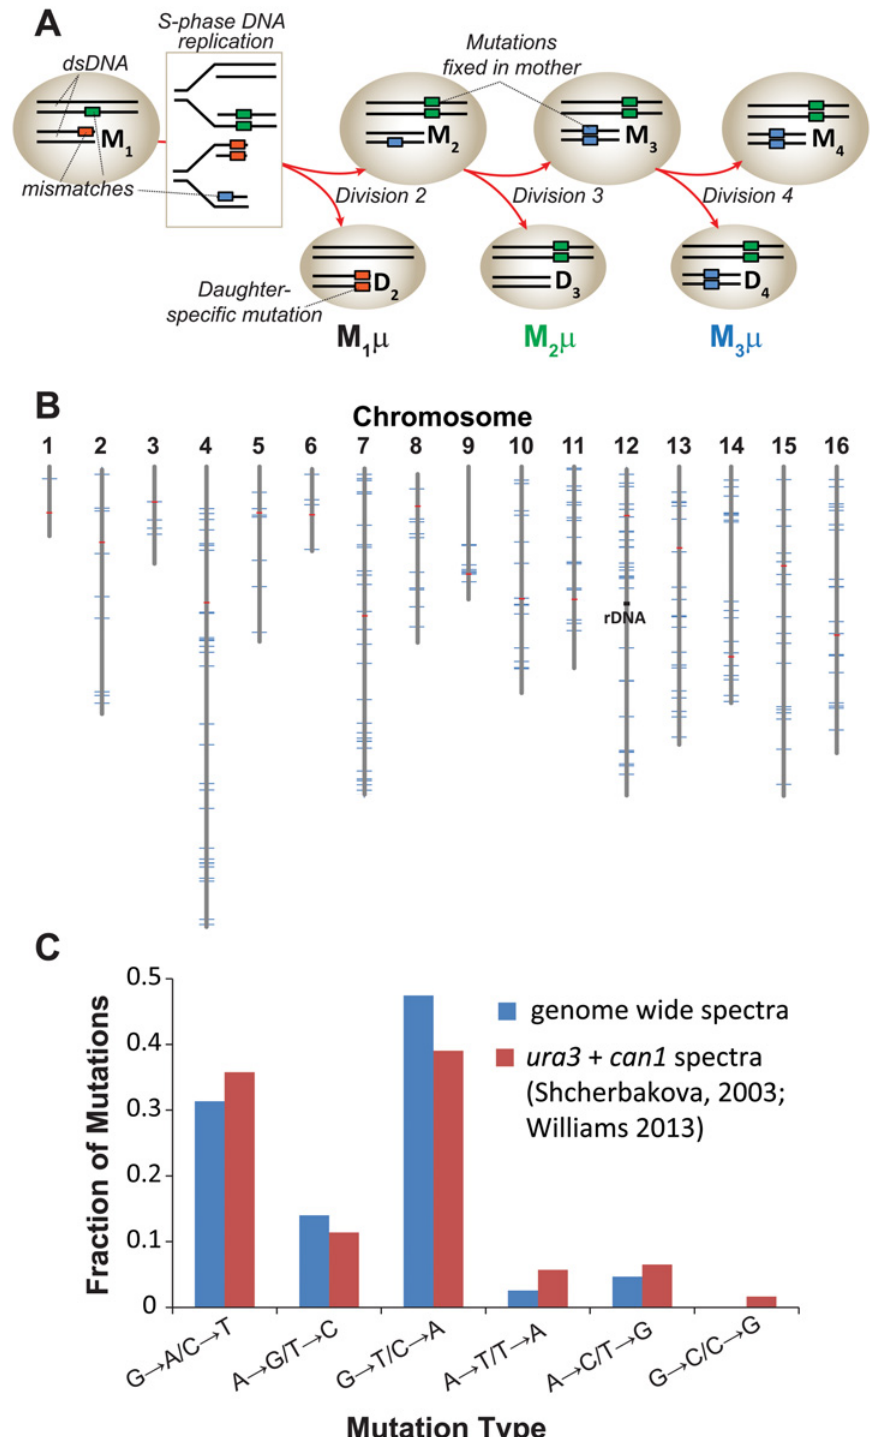
Fig 1. Mutation rate of pol2-4 msh6 Δ mother yeast cells at single cell resolution. (A) Polymerase errors (orange, green, and blue boxes) arising in maternal double-stranded DNA (dsDNA) as mismatches become mutations during S-phase DNA replication (see rectangle) and segregate to the mother (M) or daughter (D) cells. Subscript numbers following M or D indicate the division number that produced the cell (e.g. M 1 is the mother cell after one division). Red arrows indicate only one of several segregation scenarios. Single